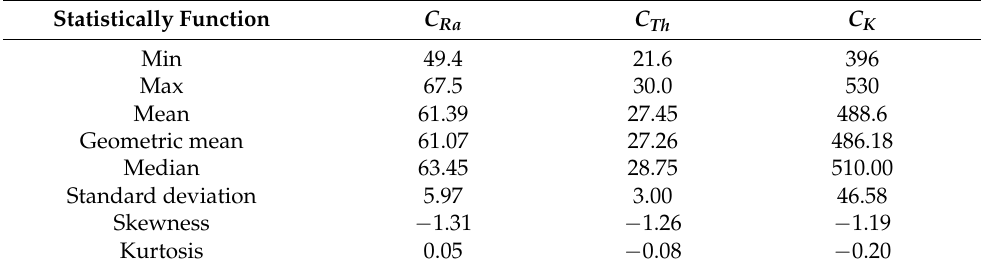
Table 4. Statistical parameters concerning the natural radionuclides activity concentrations. Statistically